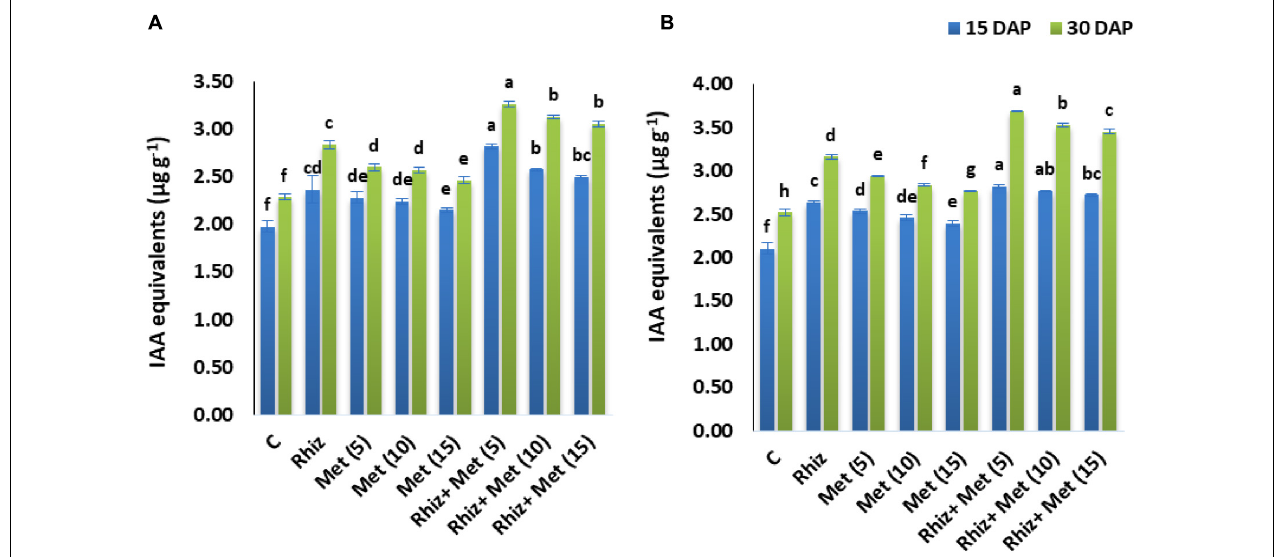
FIGURE 3 | Effect of seed inoculation and L-methionine application on indole acetic acid (IAA) production. Y -axis bar shows standard error. Treatment abbreviations: control (C), Rhizobium (CPRH-10) inoculation ( Rhiz ), L-methionine 5 mg L − 1 [Met (5)], L-methionine 10 mg L − 1 [Met (10)], and L-methionine 15 mg L − 1 [Met